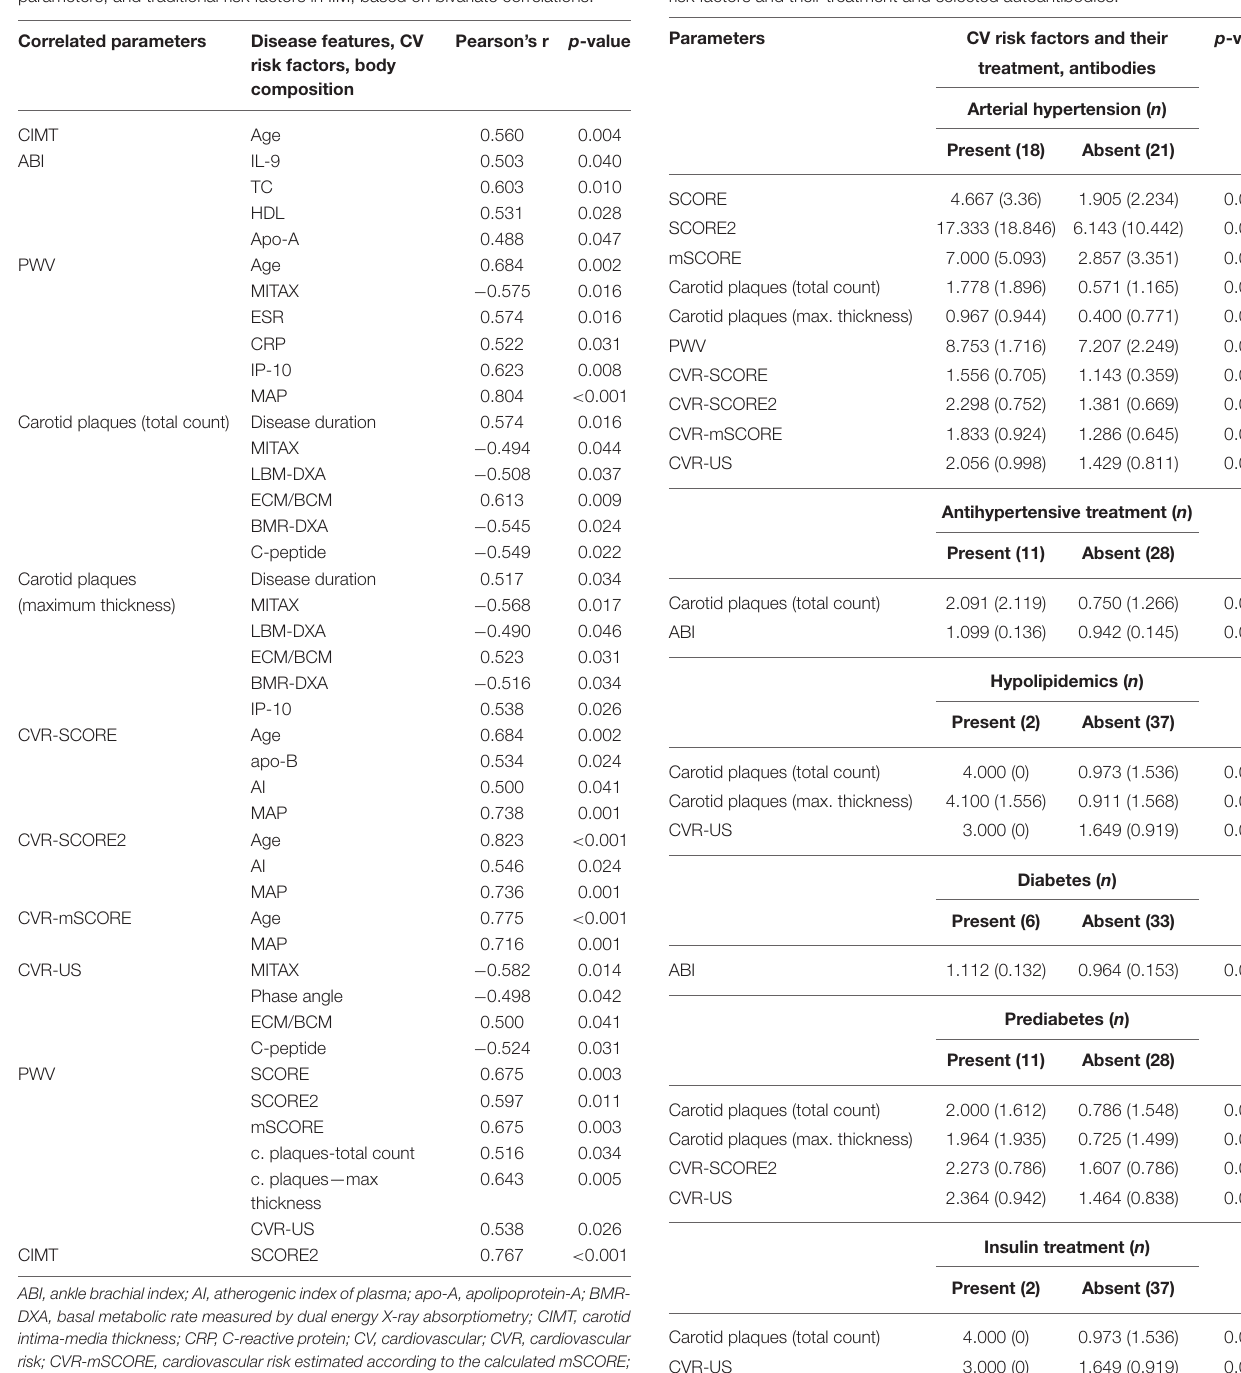
TABLE 9 | Significant differences in subclinical atherosclerosis markers and cardiovascular (CV) risk scores based on presence or absence of traditional CV risk factors and their treatment and selected